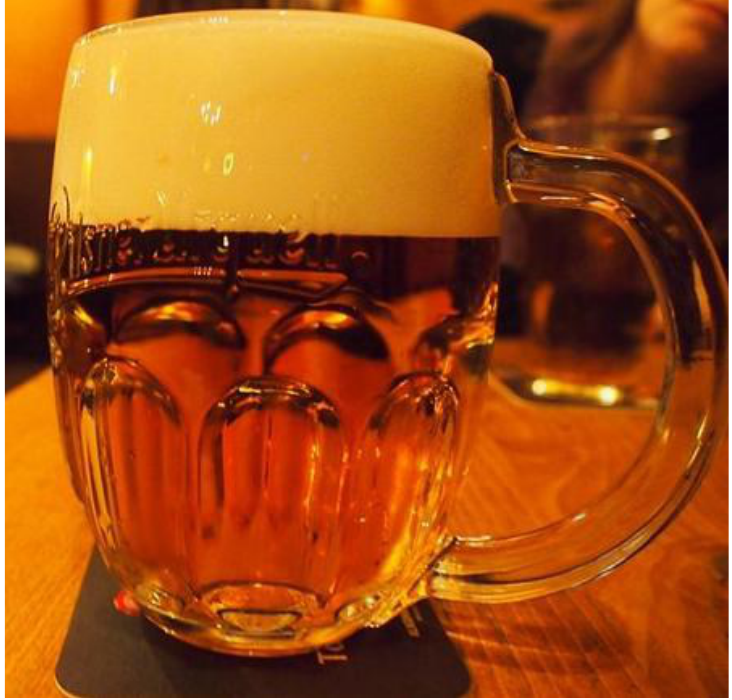
Fig. 1. Perfectly draught beer (Pilsner Urquell tank beer, restaurant Konvikt, Prague) . Fig. 2. Cold  clean glass surface – cling